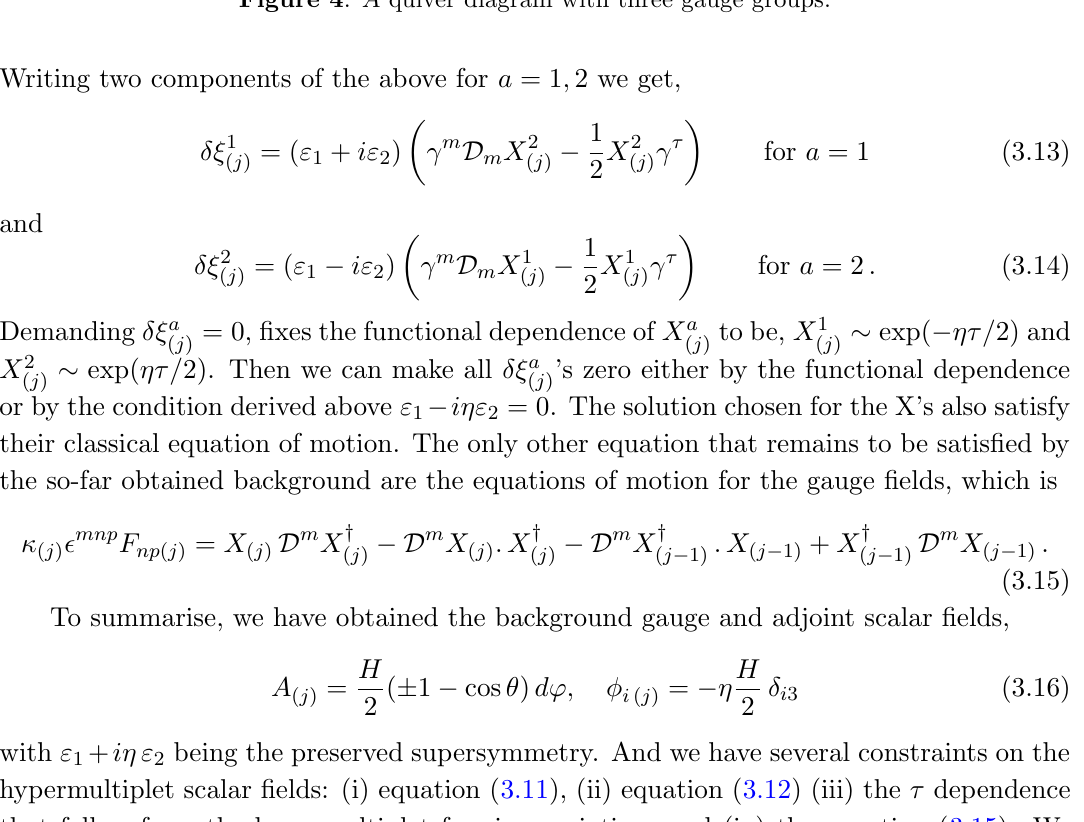
Figure 4 . b A quiver diagram with three gauge